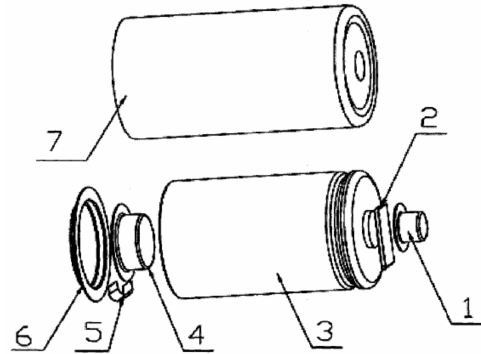
Figure 6. Schematic diagram of a low-cost current collector design with 1: positive terminal, 2: Ni tap, 3: cell assembly, 4: negative electrode bottom plate, 5: Ni tap, 6: negative terminal, and 7: plastic case